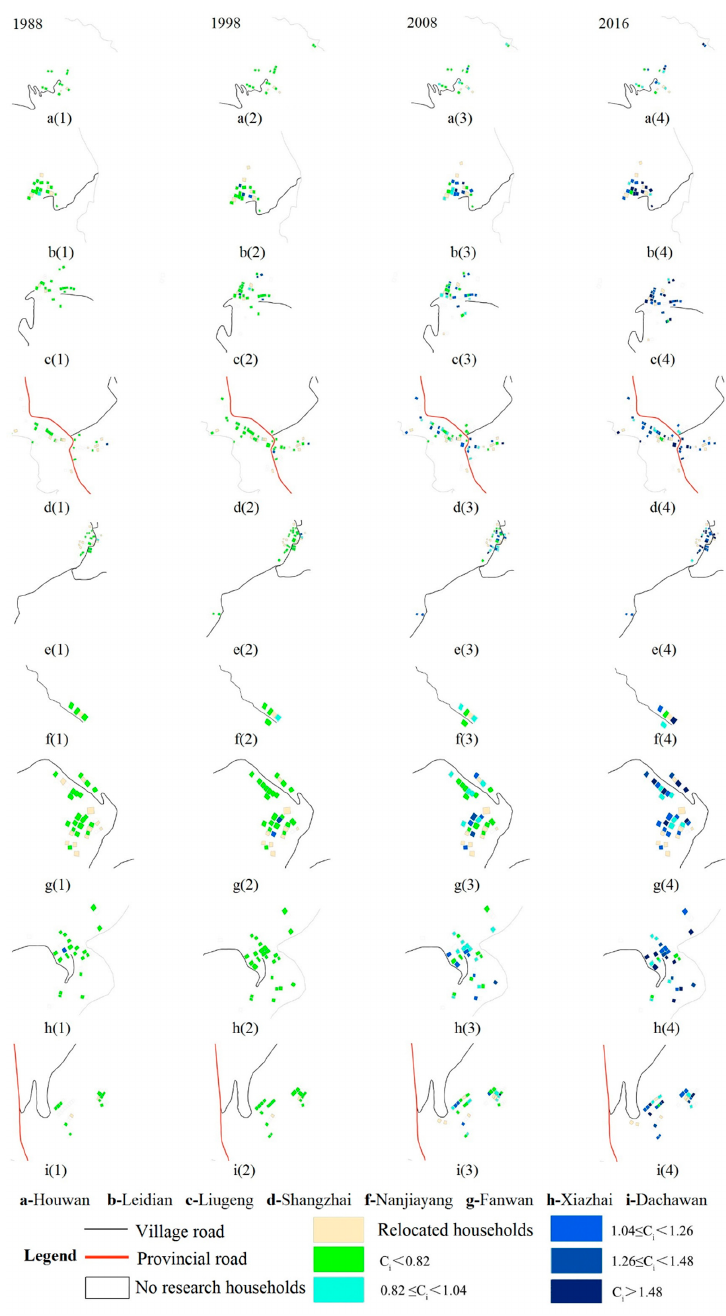
Figure 4. Spatial variation of households’ livelihood assets in 1988, 1998, 2008, and 2016.